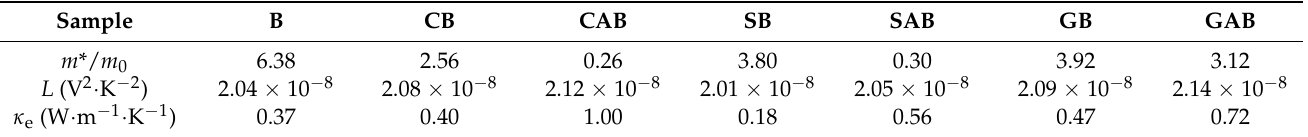
Table 1. Thermoelectric parameters of Bi 2 Te 3 -based films at 300